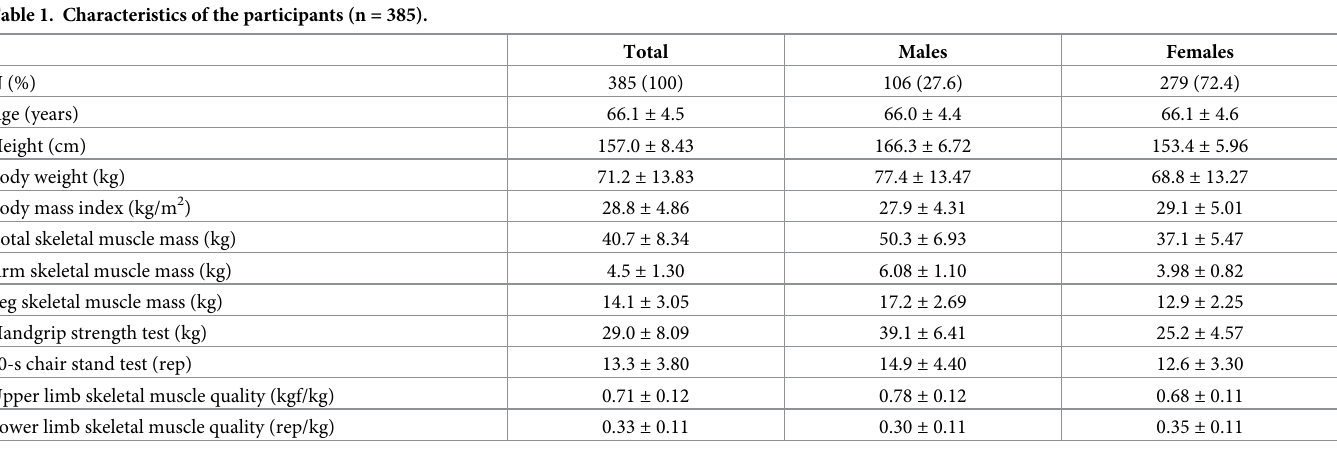
Table 1. Characteristics of the participants (n = 385).